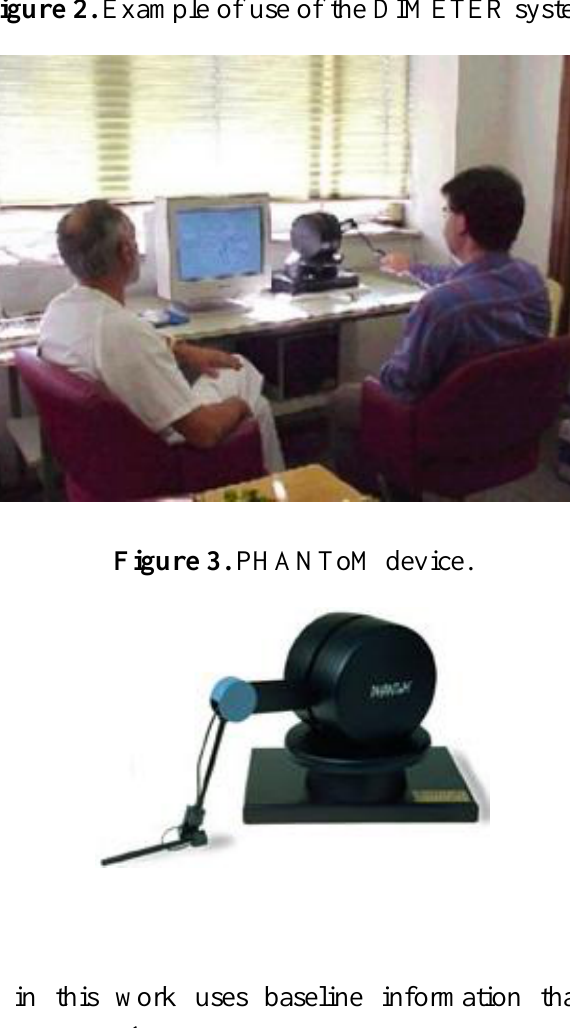
Figure 2. Example of use of the DIMETER system.